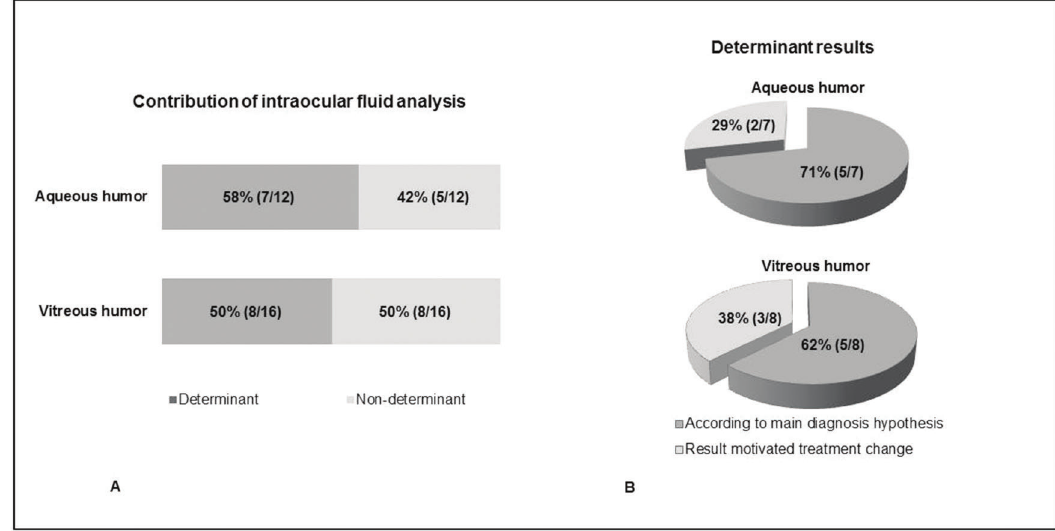
Figure 1 - A. Contribution of intraocular fluid analysis in patients with uveitis; B. Determinant results found for aqueous and vitreous humor. The results were considered determinant when they were in accordance with the initial clinical hypothesis (B. dark gray) or changed the initial clinical diagnosis (B. light